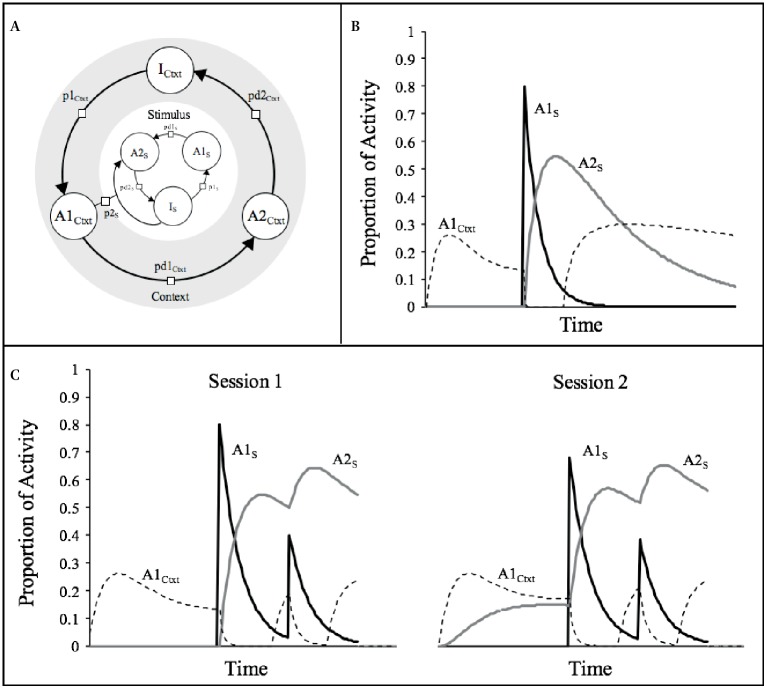

(A) A representation of the context-stimulus relationships assumed by SOP. (B) Courses of activity for a typical stimulus (s; duration = 1 moment, p1S = 0.8, pd1S = 0.1, pd2S = 0.02) and the context (p1Ctxt = 0.05; pd1Ctxt = 0.1; pd2Ctxt = 0.02) according to SOP rules of activity. (C) Simulations of the theoretical processes involved in two training sessions with two presentations of a 1-moment stimulus within the context.